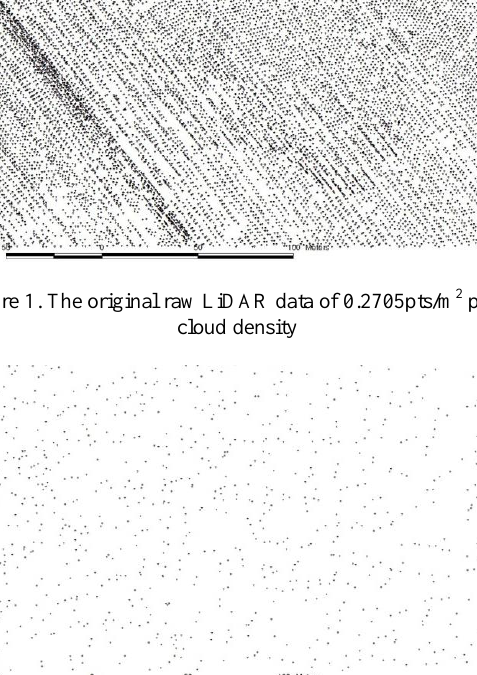
Figure 2. Reduced raw LiDAR data down to 0.0175pts/m 2